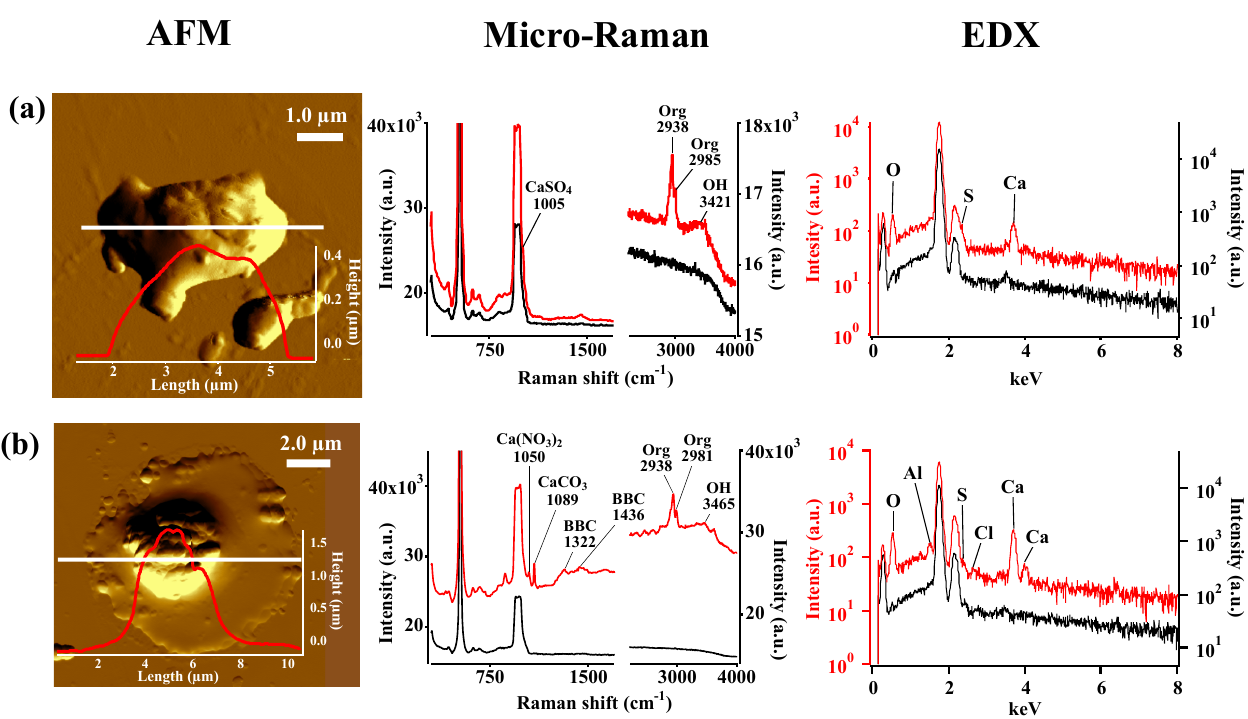
Figure 10. AFM topographic images of representative Ca-rich particles in IN active (a) and non-active (b) groups, and their corresponding Raman and EDX spectra. The AFM images were obtained in probe amplitude mode. The inset in the AFM image shows the scanned height along the white transect of each particle. The red and black curves indicate the spectra of the particle and the substrate background,